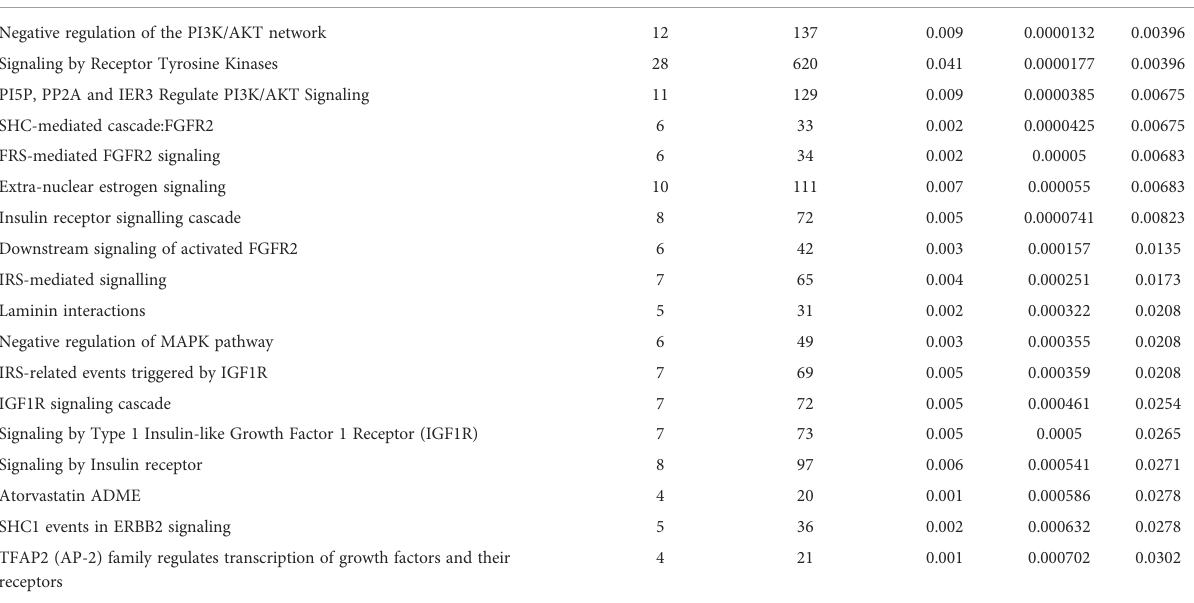
TABLE 3 Reactome pathway analysis of target genes for hsa- miR-223-5p.